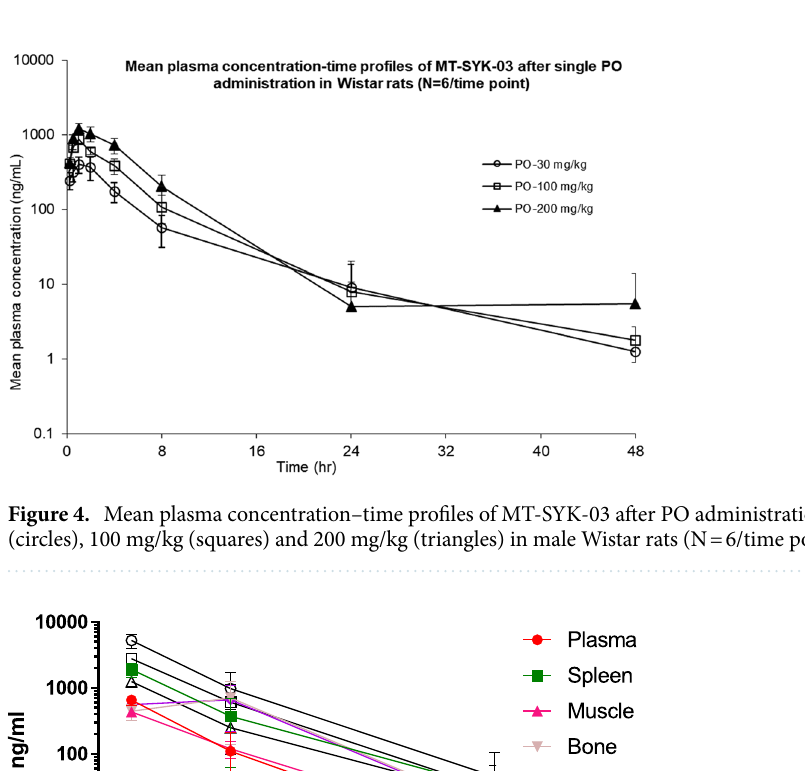
Table 1. The main pharmacokinetic parameters after oral MT-SYK-03 administration in rats in three single doses and rabbits.